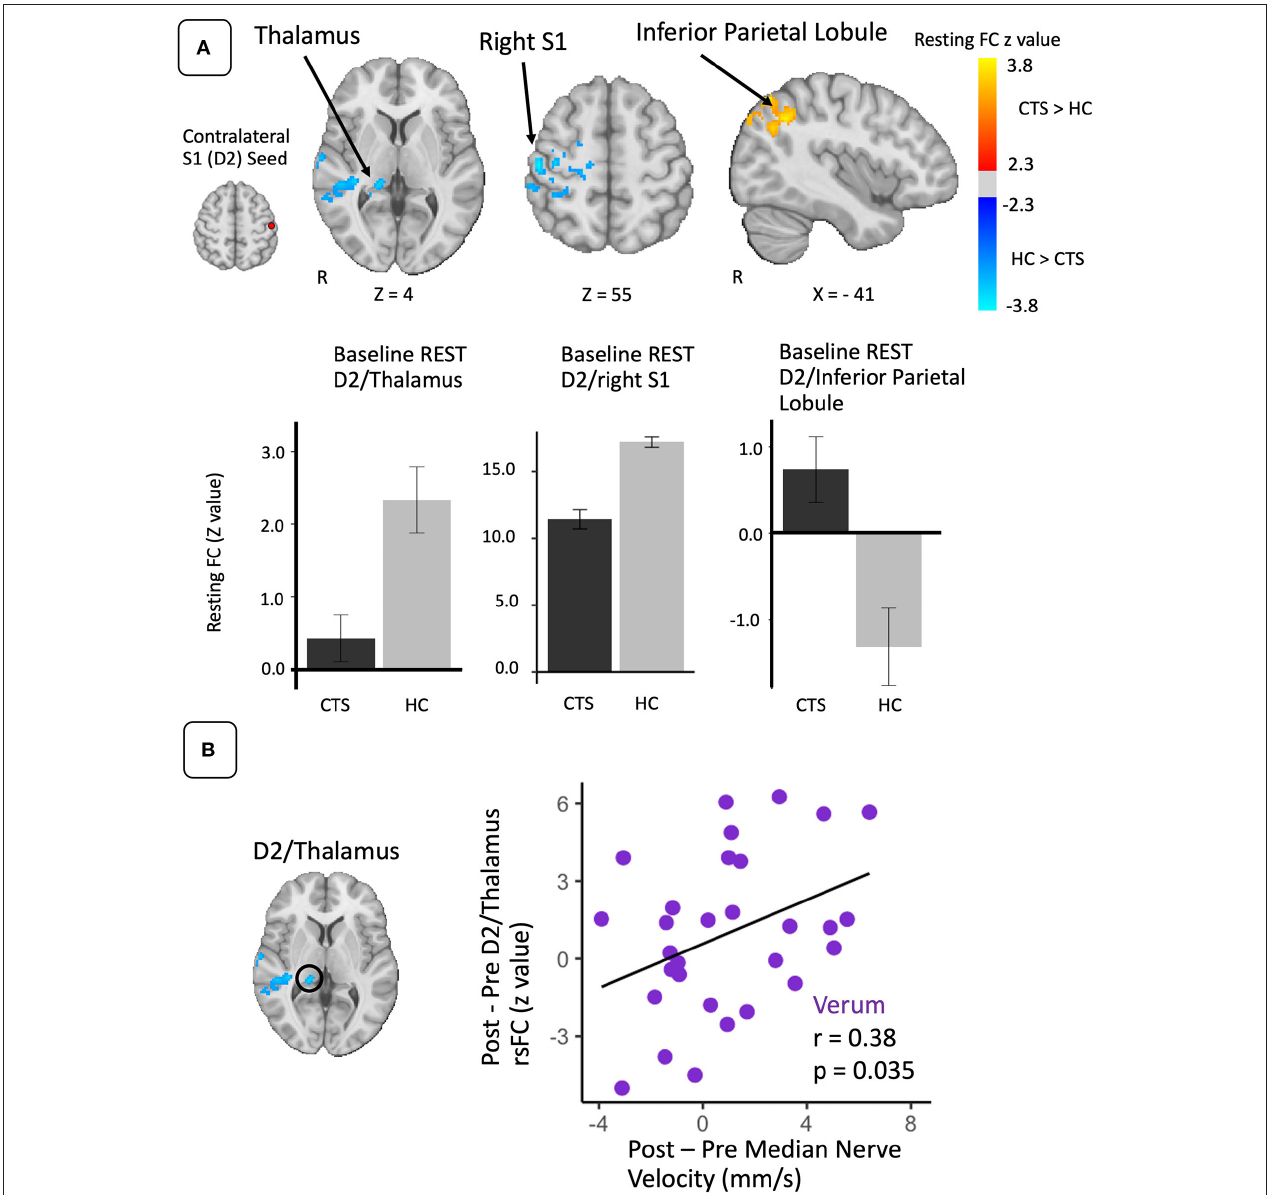
FIGURE 1 | Resting state S1 connectivity is altered in CTS compared to healthy controls and linked with post-therapy changes in peripheral nerve function. (A) During REST, compared to healthy controls, the D2 S1 representation (seed) contralateral to more affected hand in CTS was less functionally connected to the right pulvinar nucleus of the thalamus and right (ipsilateral) S1. D2 was also more functionally connected to left inferior parietal lobule in the CTS group. (B) Increases in resting D2/thalamus connectivity following verum EA therapy were correlated with post-therapy improvement in median nerve conduction velocity. N.b. S1, primary somatosensory cortex; D2, S1 cortical representation of the second digit of the hand; FC, functional connectivity. ROIs for longitudinal analyses were defined from regions showing differences between CTS patients and healthy controls in resting state D2 functional connectivity at baseline.